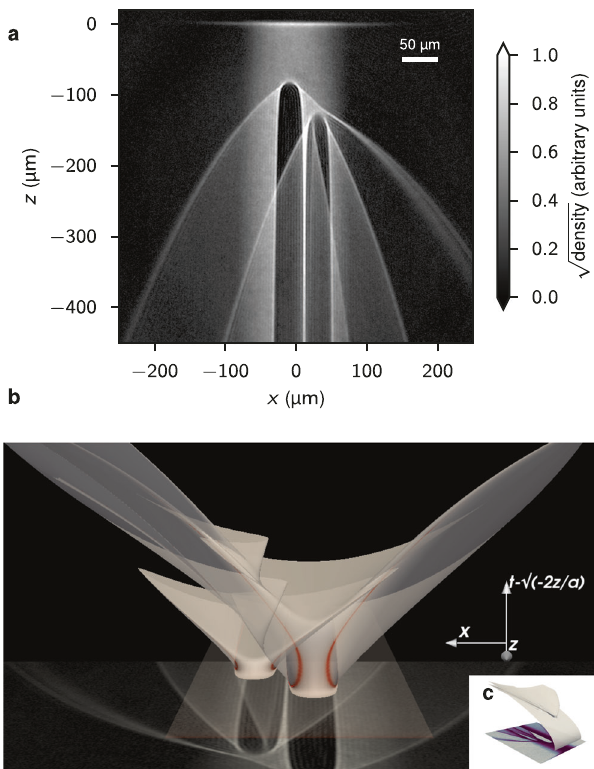
Fig. 1 Caustic networks from two repulsive potentials in an atom laser. a Experimental data averaged over 15 runs. The atom laser propagates from top ( z = 0) to bottom. Each barrier is Gaussian-shaped [Eq. (2)] with U 0 / k = 23.1 μ K and σ = 10.3 μ m. The left barrier is positioned h = 85 μ m below B the injection point of the atoms ( ε = 0.95, see Eq. (3)). The right barrier is offset from this by ( Δ x , Δ z ) = (39, − 42) μ m ( ε = 0.64). b A numerical rendering of the classical trajectories as a sheet ð x i ; t i Þ7!ð x ; z ; t i (cid:2) the singularities of which appear as caustics when projected down into the ( x , z ) imaging plane where the experimental data is shown again. Here, t is the vertical direction, while x increases to the left, and z decreases into the image. Red shading denotes regions where det J (cid:2) 1 is large [Eq. (1)], corresponding to the caustics when projected onto the imaging plane. c A numerical rendering of the classical trajectories as a sheet ( x i , t i ) ↦ ( x , z , t i ), which now includes the free-fall